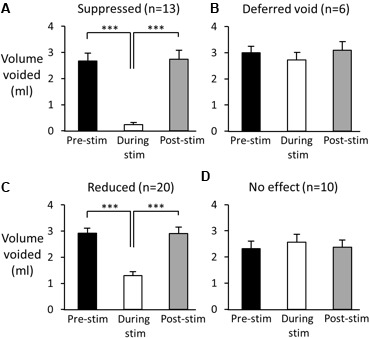
Effect of high frequency stimulation of the pelvic nerve on voiding. Black bars show mean volume of voids prior to stimulation. Open bars: volume of urine voided during pelvic nerve stimulation; grey bars volume of first void post stimulation. (A–C) Examples of suppressed (A), deferred (B), and reduced voiding (C). In each case normal voiding resumed once the stimulation ceased. (D) On 10 further occasions the stimulus was ineffective. Data from 49 stimulation tests in six rats. ∗∗∗p < 0.001 (repeated measures ANOVA, Tukey’s post hoc test).